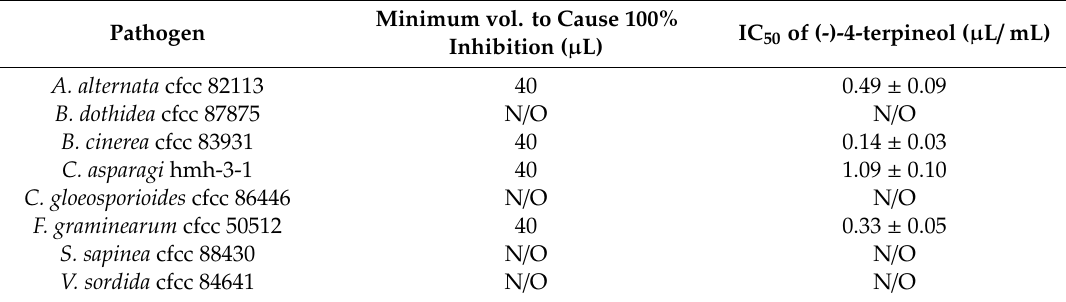
Table 6. IC 50 of commercial (-)-4-terpineol on fungal pathogens of